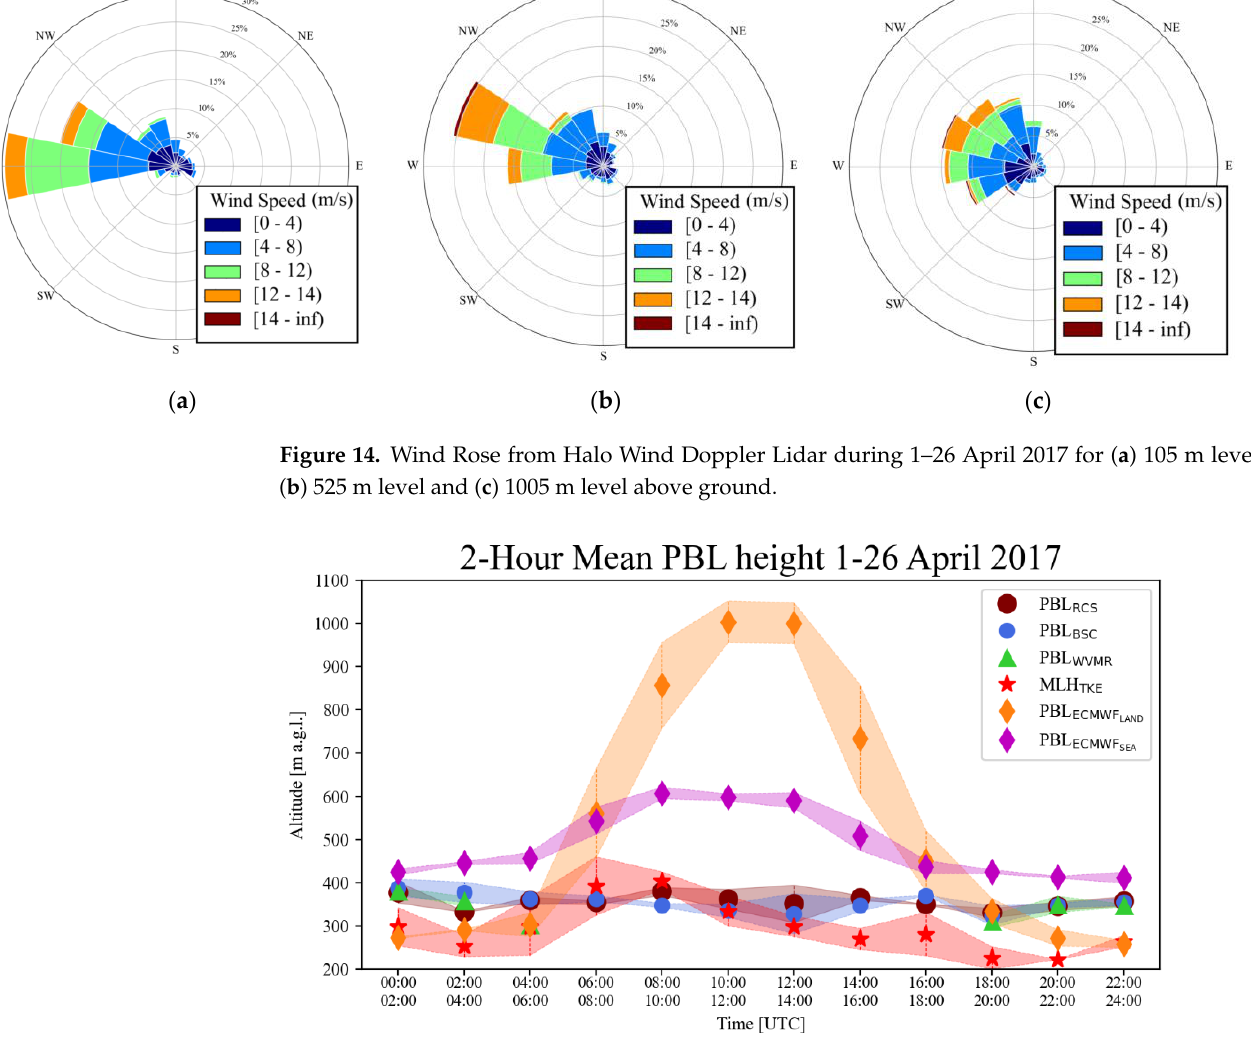
Figure 15. Mean PBL height calculated every 2 h from WCT on RCS (brown circles), BSC (blue circles), WVMR (green circles), TM on TKE dr (red stars) and ECMWF land bin (orange diamonds) and sea bin (purple diamonds) as described in Figures 8 and 12. Standard deviations are displayed with the same color shading for each product.